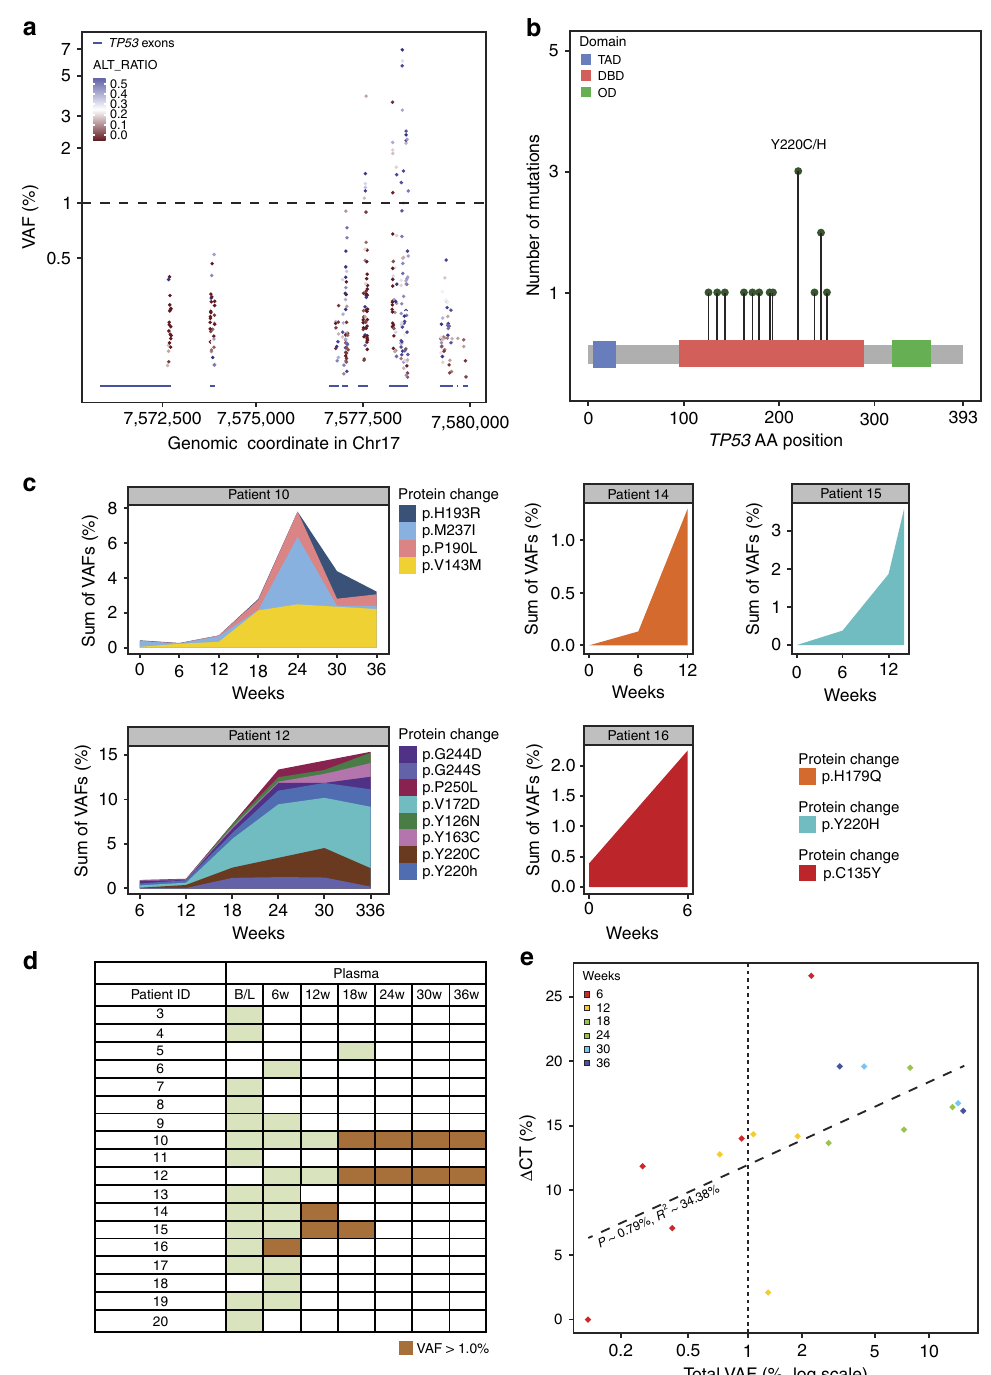
Figure 2 | TP53 mutations in patients with DDLPS treated with the HDM2 antagonist SAR405838. ( a ) TP53 mutation VAF in cfDNA samples from patients with DDLPS in the SAR405838 MTD expansion cohort. The X axis shows the genomic location of TP53 exons and UTRs (blue bars). Each dot indicates the presence of one TP53 variant. Dotted line indicates VAF of 1.0%. ( b ) All identified mutations in TP53 were located in the DNA binding domain. The Y axis is the number of mutations observed at each position; the X axis represents the amino-acid sequence of TP53 . Each green dot represents a missense mutation. The most frequently altered amino-acid position (Y220) is indicated. ( c ) TP53 mutations at VAF 4 1.0% were clustered in five patients. The Y axis shows the sum of TP53 mutation VAF (allele burden) and the X axis shows weeks of treatment. Each mutation is represented by one colour. ( d ) Patient TP53 mutation status. Green indicates time points for which cfDNA samples were collected and sequenced, but no TP53 mutations were identified at VAF 4 1.0%. Orange indicates time points for which TP53 mutations were identified at VAF 4 1.0%. ( e ) Correlation between percent change in tumour size by CT (the Y axis) versus total TP53 mutation VAF (mutation burden; the X axis, log scale) across all patients for which at least one TP53 mutation was identified at VAF 4 1%. Each dot represents one time point for one patient and dots are coloured according to the time point. The vertical dotted line indicates TP53 mutation VAF ¼ 1.0%. B/L, baseline; cfDNA, cell-free DNA; CT, computed tomography; DBD, DNA binding domain; DDLPS, de- differentiated liposarcoma; MTD, maximum tolerated dose; OD, oligomerization domain; TAD, transactivation domain; VAF, variant allele frequency.